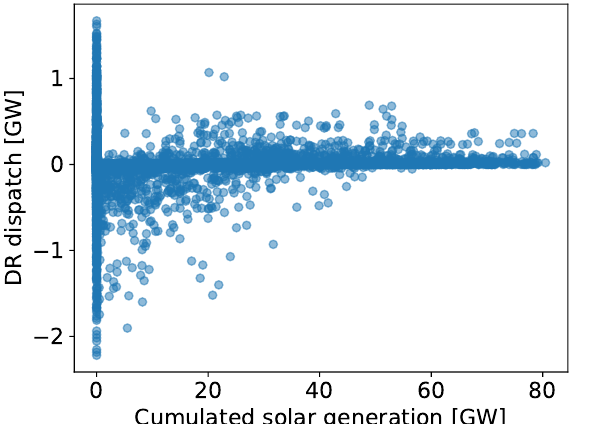
Figure 6. Correlation of the DR dispatch and the cumulated solar generation (each point represents one hour of the year).